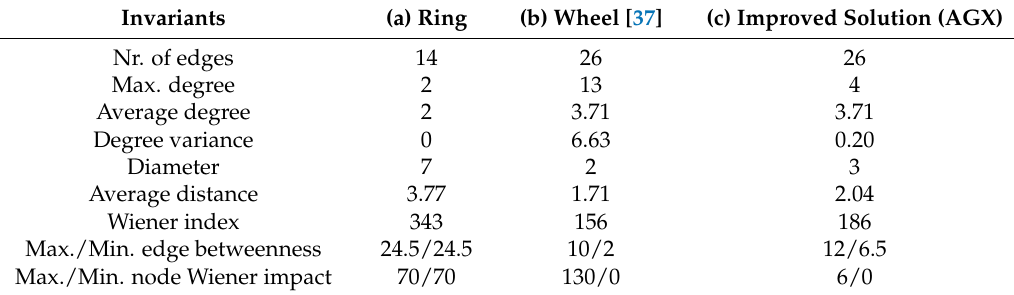
Figure 3. 2-connected topologies: ( a ) ring; ( b ) wheel; and ( c ) improved solution (AGX). Table 3. 2-connected topologies (14